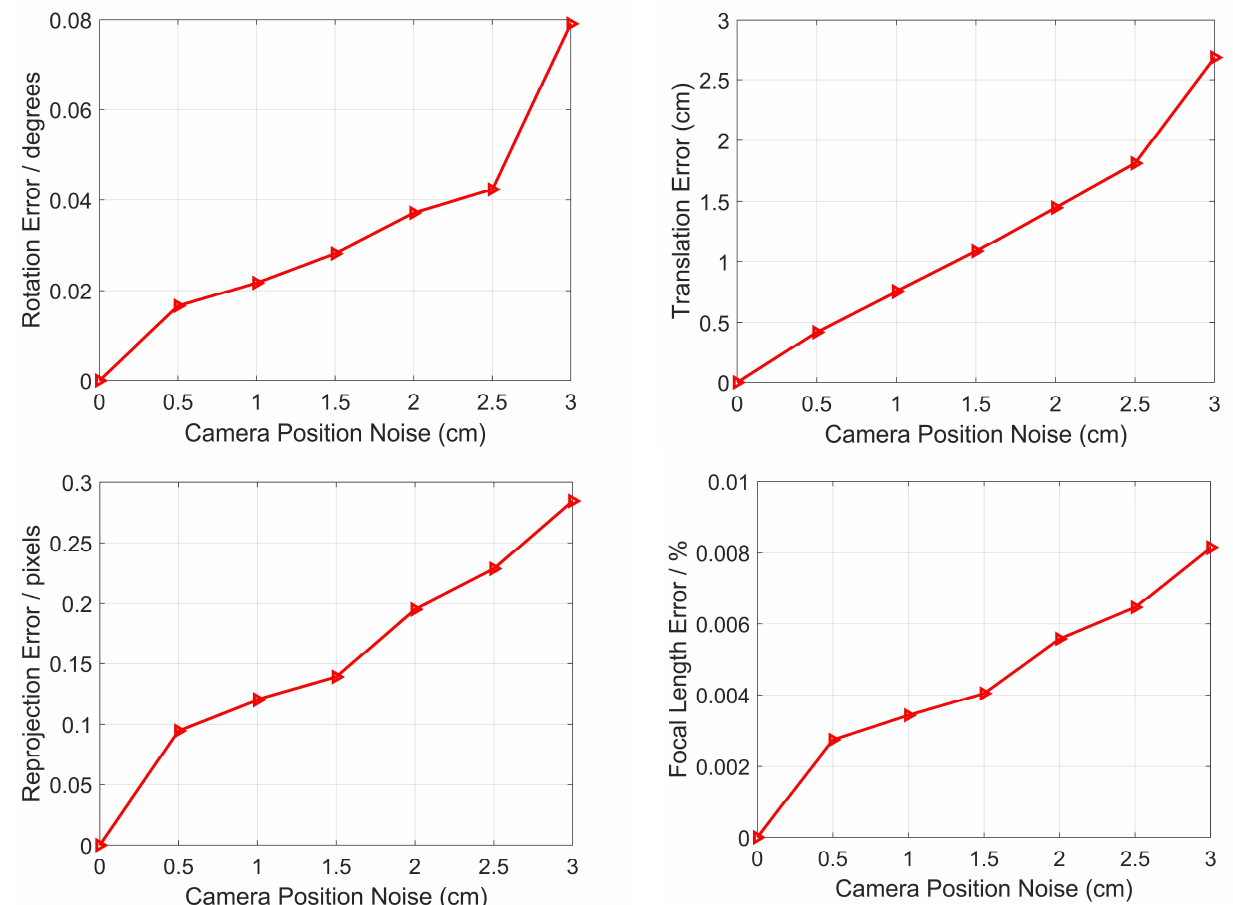
Figure 5. Robustness to camera position noise for the rotation error ( top left ), the translation error ( top right ), the reprojection error ( bottom left ) and the relative focal length ( bottom right ).